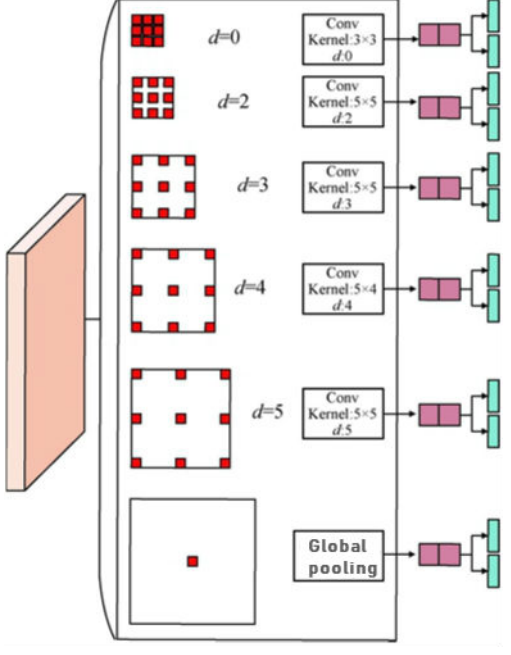
Figure 8. Filter pyramid based on dilated convolution